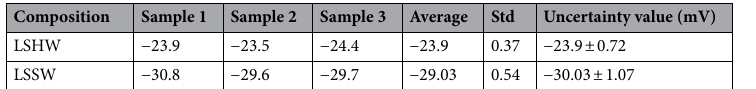
Table 11. ZP values of silica NPs in LSHW and LSSW compositions.